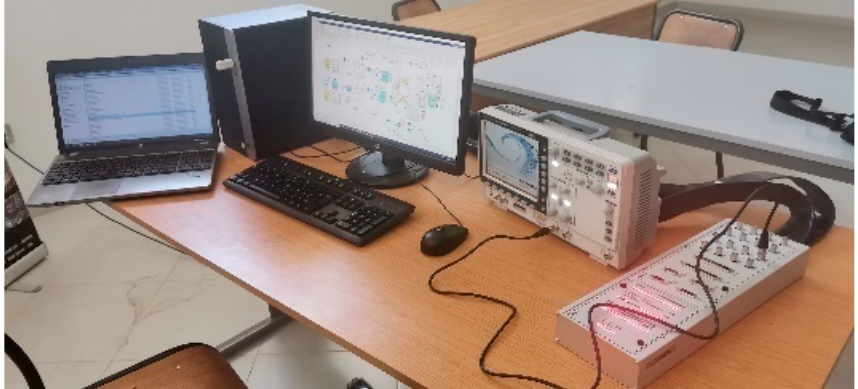
Figure 19. Image of the test bench.